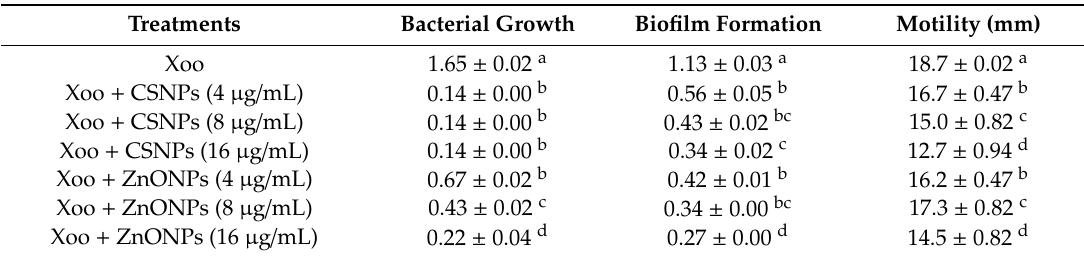
Table 2. The in vitro inhibitory e ff ect of chitosan nanoparticles (CSNPs) and zinc oxide nanoparticles (ZnONPs) at di ff erent concentrations (4, 8, and 16 µ g / mL) on the growth, biofilm formation,